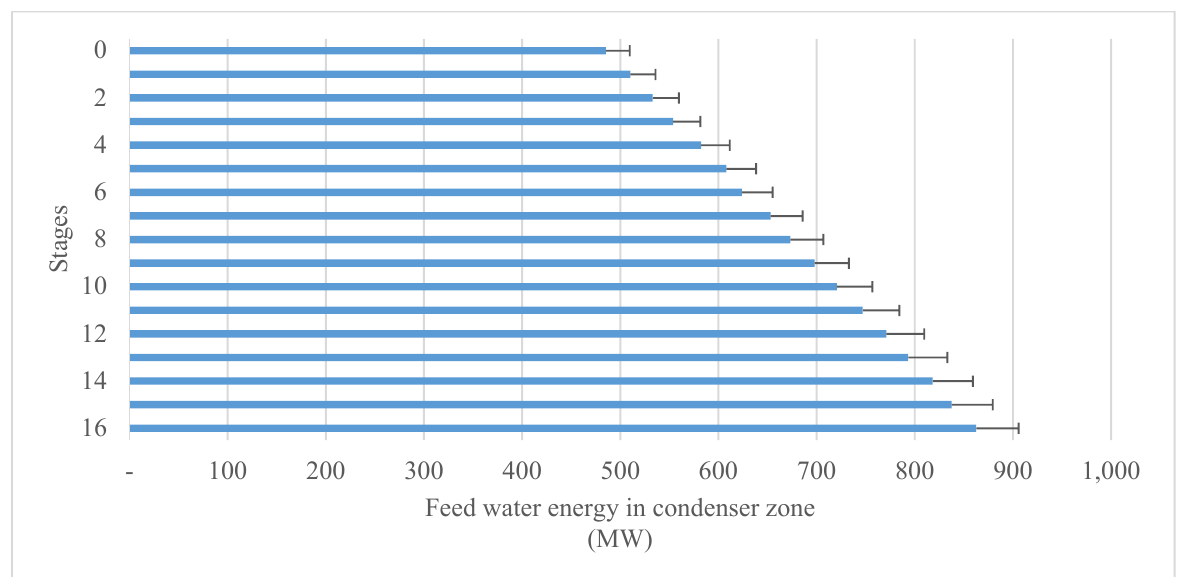
Figure 8. Energy increment of feed water in condenser zone; stage (0) denotes the initial condition (flow of feed water before entering stage 16 of the plant as intake water).